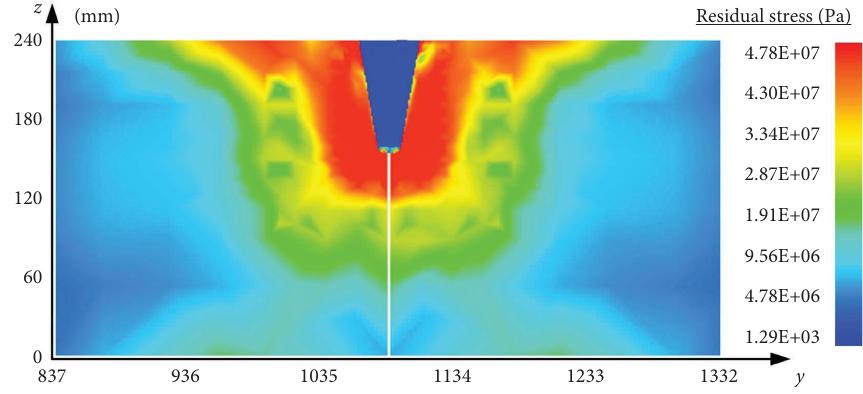
Figure 7: Residual stress of the antenna’s azimuth